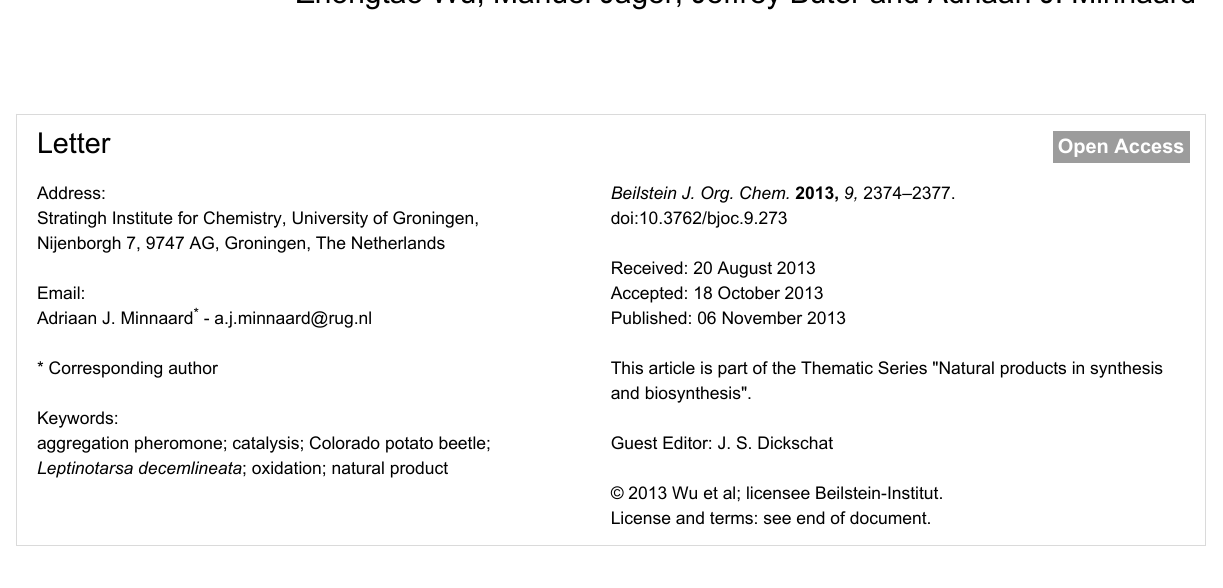
dihydroxy-3,7-dimethyl-6-octen-2-one ( 1 , Figure 1) [8]. ( S )- 1 is attractive for both male and female Leptinotarsa decemlineata while ( R )- 1 is inactive or inhibitory, as was demonstrated by the inactivity of the racemate [7]. Since then, ( S )- 1 has been synthe- sized by the groups of Oliver [8], Mori [9], Chauhan [10]